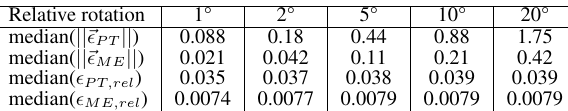
Table 1. Median absolute and relative errors with and without model extension. Relative rotation 1° 2°